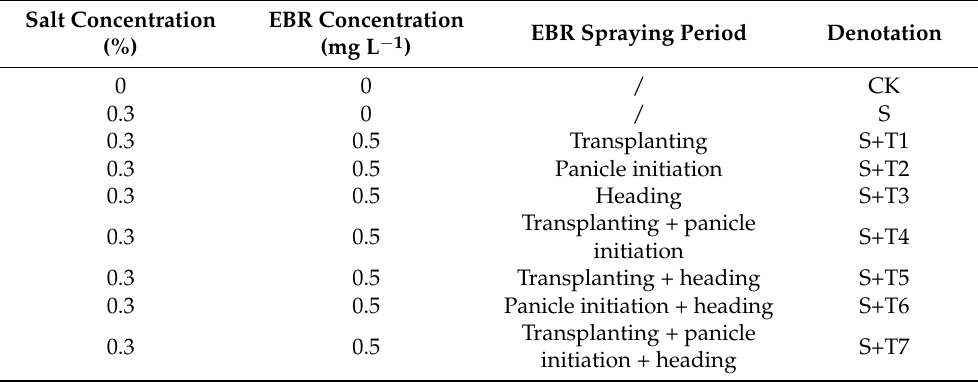
Table 1. Treatment designs in the pot